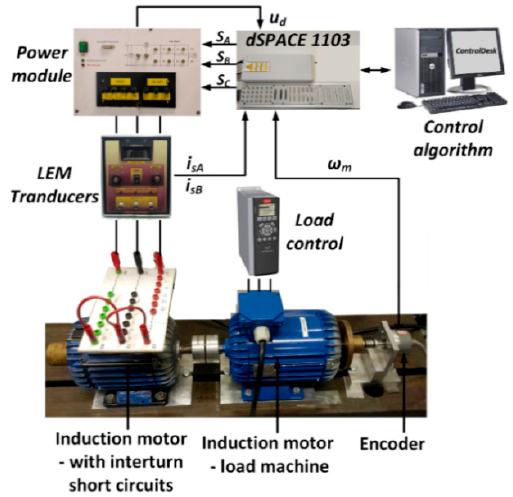
Energies 2019 , 12 , x FOR PEER REVIEW 17 of 22 Figure 13. Schematic diagram of experimental setup. Figure 13. Schematic diagram of experimental setup.